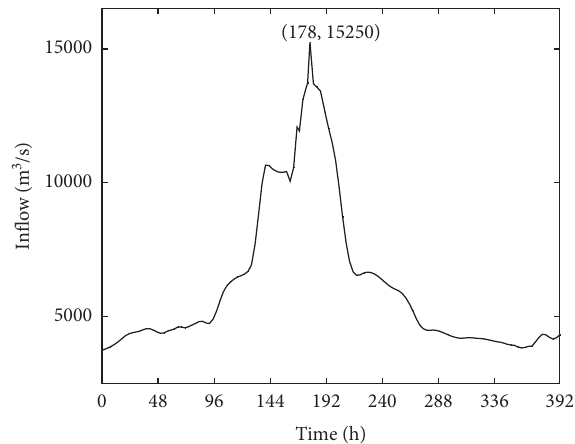
Figure 7: The maximum design flood hydrograph at the PBG dam site.